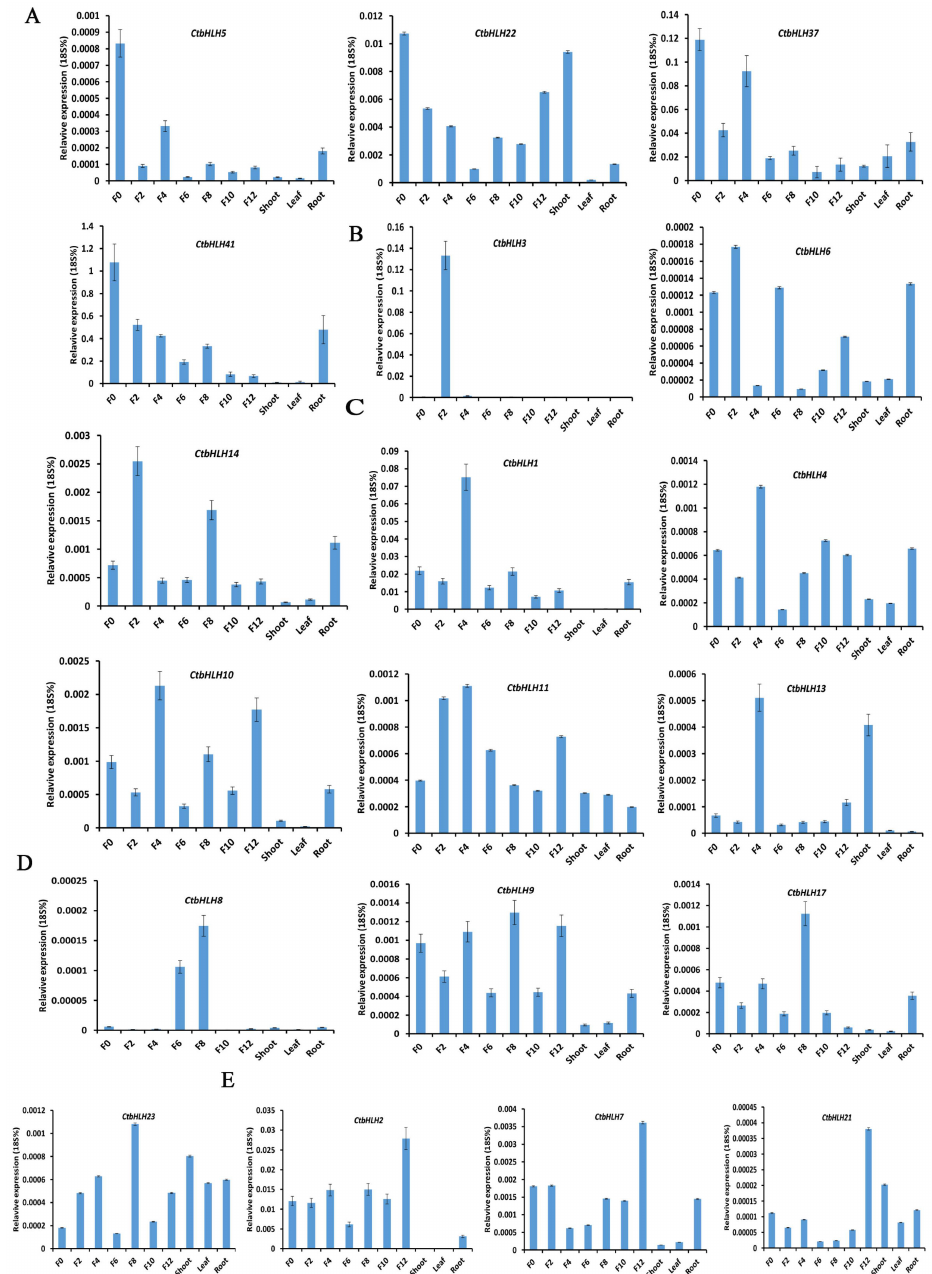
Figure 4. Expression profiles of 19 sa ffl ower bHLH genes during di ff erent developmental stages as determined by qRT-PCR analysis. ( A ) Includes genes that were highly expressed at F0. ( B ) Includes genes that were highly expressed at F2. ( C ) Temporal expression of genes at F4. ( D ) and ( E ) Transcript abundance of genes found at F8 and F12, respectively. Expression analysis was normalized using the 18S rRNA gene as an internal reference. Error bars were estimated from the di ff erences in the expression patterns of three independent